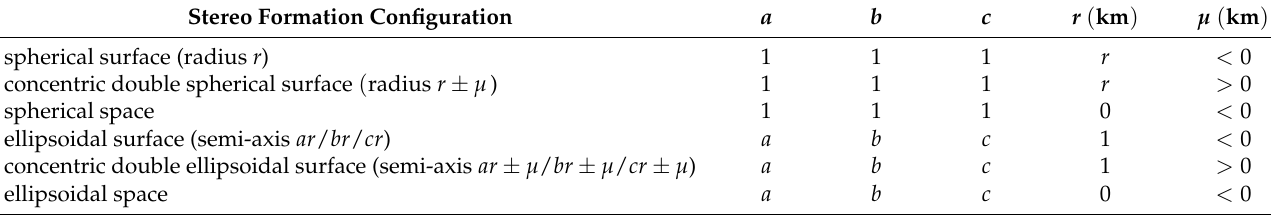
Table 2. Stereo formation configurations and bifurcating